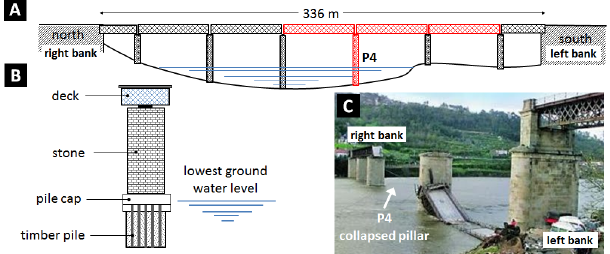
Fig. 2. The Hintze Ribeiro bridge. (A) Schematic representation of the bridge with the collapsed components highlighted in red; (B) schematic representation of the bridge pillars; (C) picture of the bridge after the